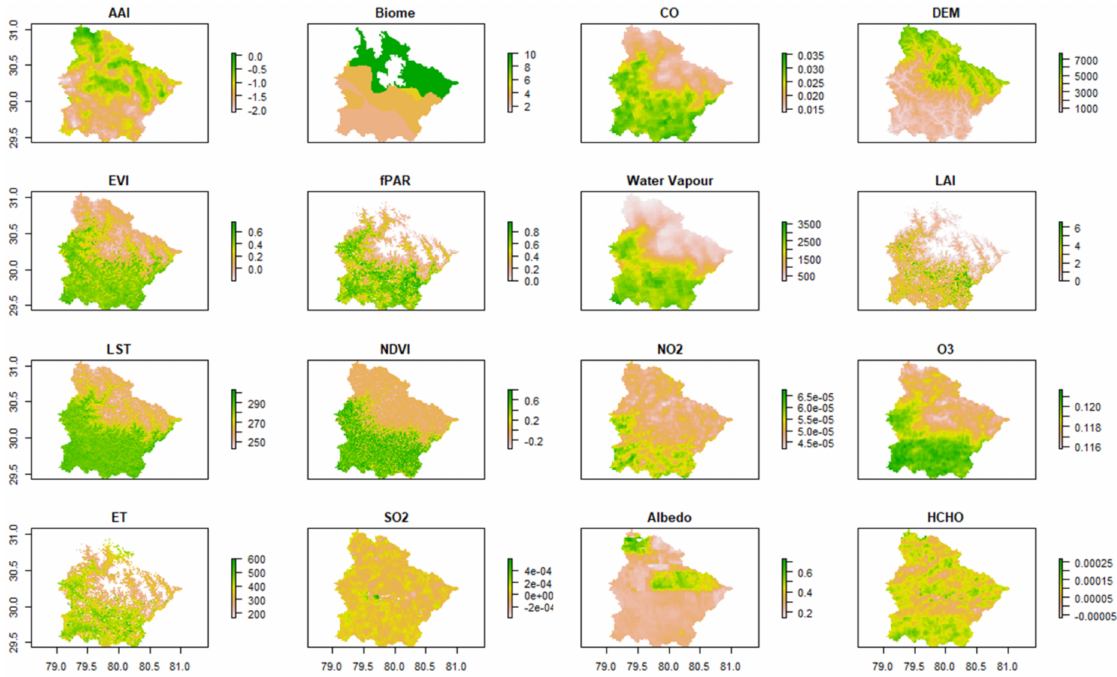
Figure 5. Spatial Distribution of various input